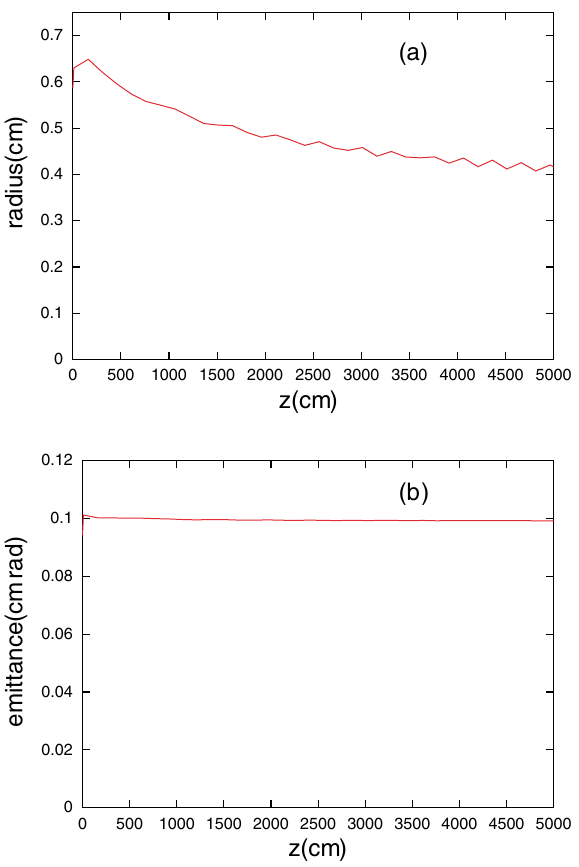
FIG. 8. (Color) Beam radius and emittance as functions of axial position when ion background is negligible.